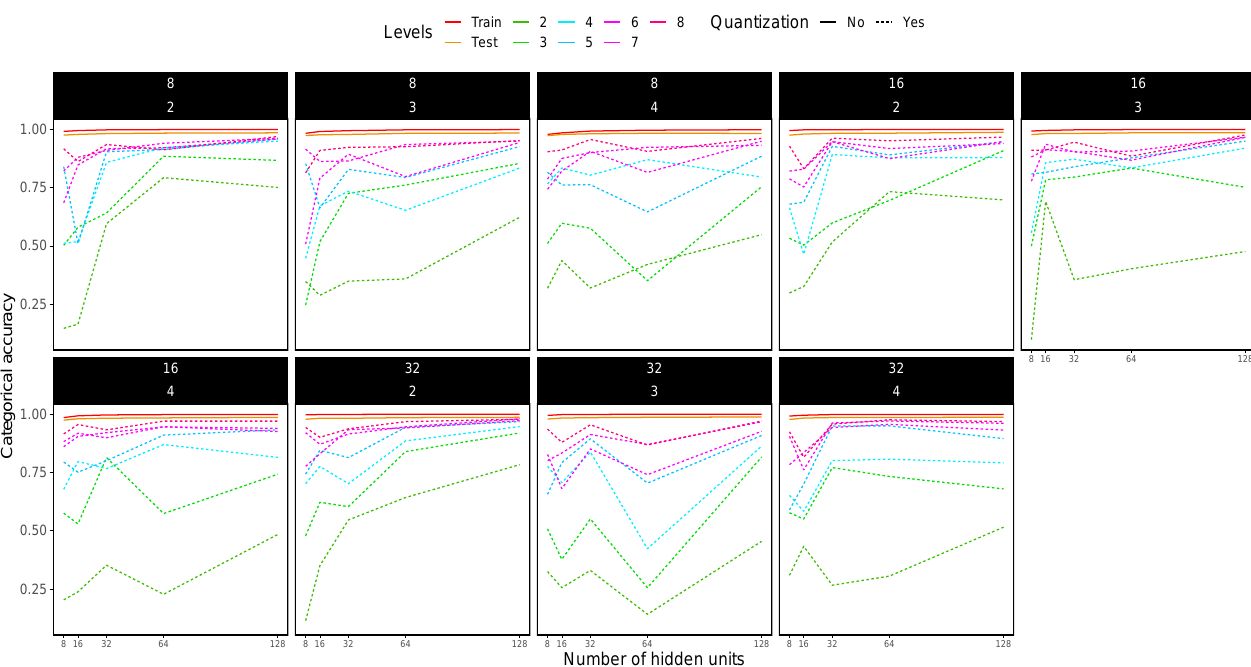
Figure 10. Categorical accuracy for the MNIST dataset using 1-CNN (i.e., one convolutional layer + one pooling layer). Only one hidden layer was used, with hidden units ranging from 8 to 128 ( x axis). Each dashed line in the plots shows the accuracy for different quantization levels, while solid lines indicate no quantization. Each box in the figure shows a particular experiment: convolutional layer with 8, 16 and 32 filters (top number of the box) and pooling with 2 × 2, 3 × 3 and 4 × 4 matrices (bottom number of the